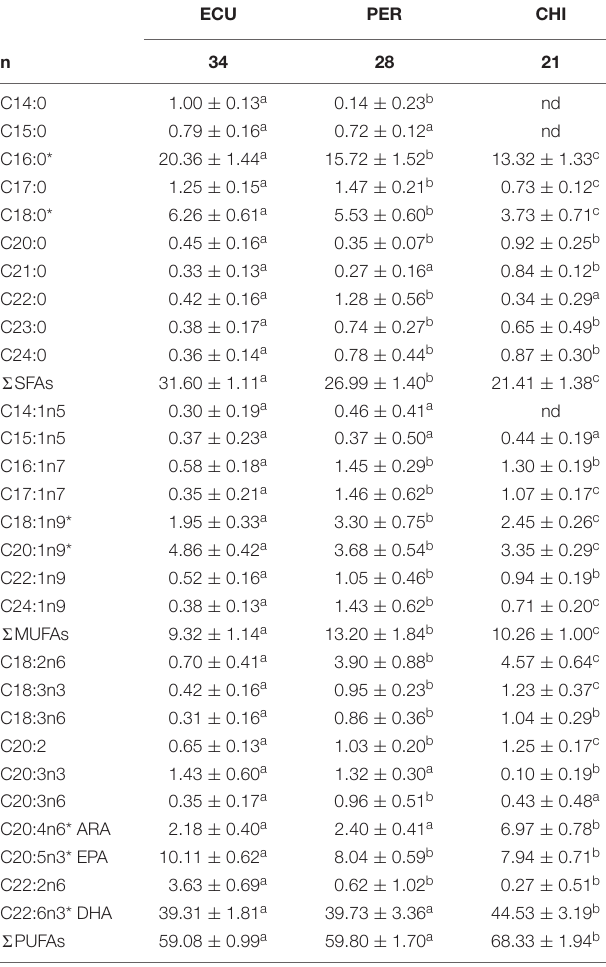
TABLE 1 | Fatty acid profiles (%, mean ± SD) in muscle of Dosidicus gigas sampled from the waters off the Ecuadorian, Peruvian and Chilean Exclusive Economic Zone (ECU, PER, and CHI,